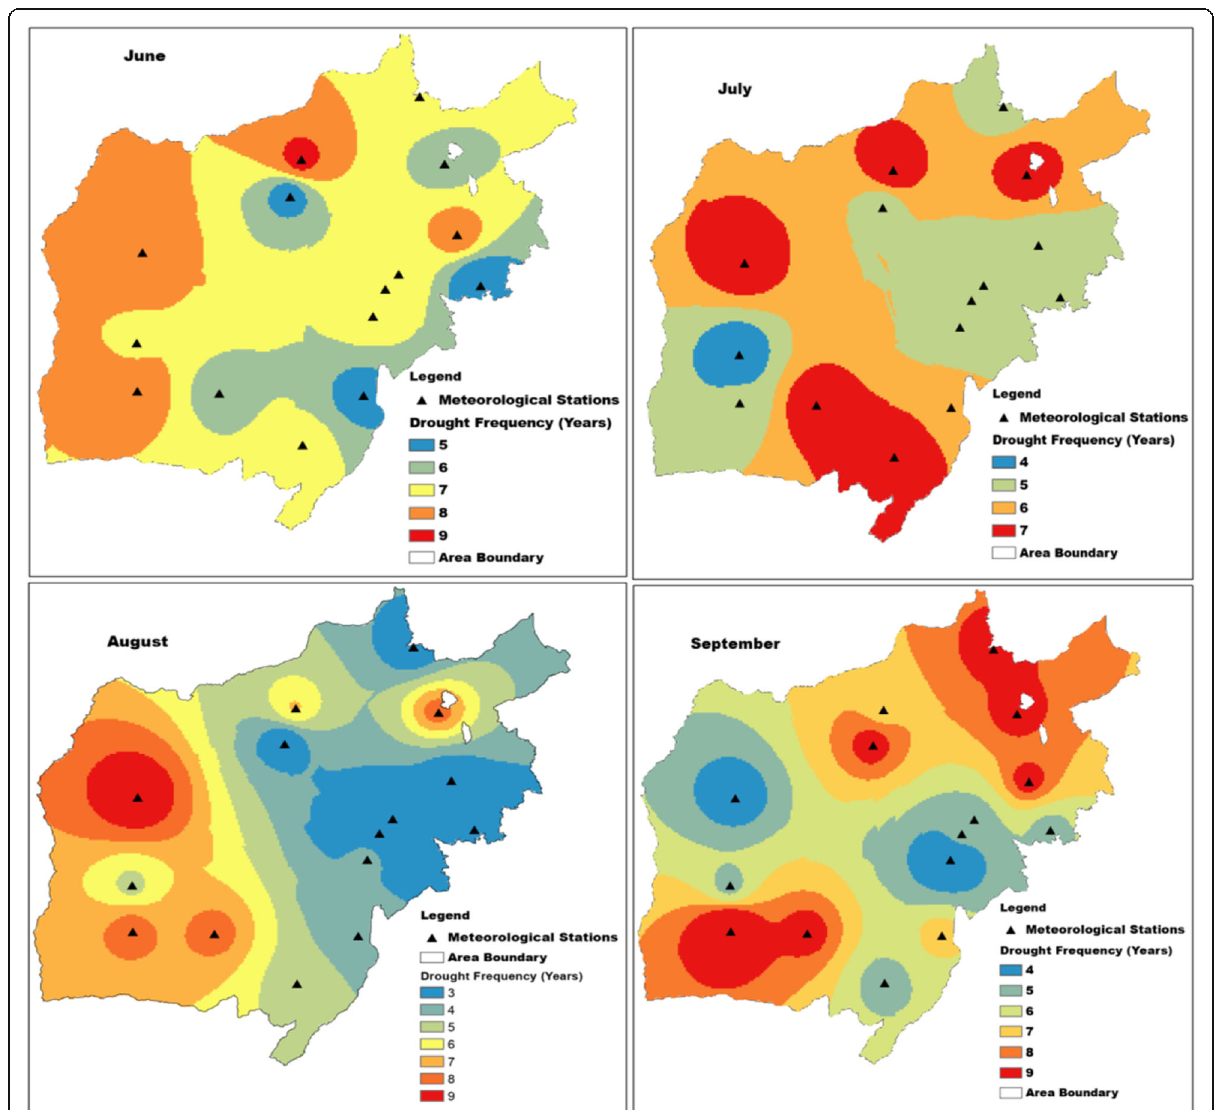
Fig. 6 The 1-month timesteps spatial pattern of drought frequency events (SPI ≤ − 1.0) for the big rainy months of June, July,